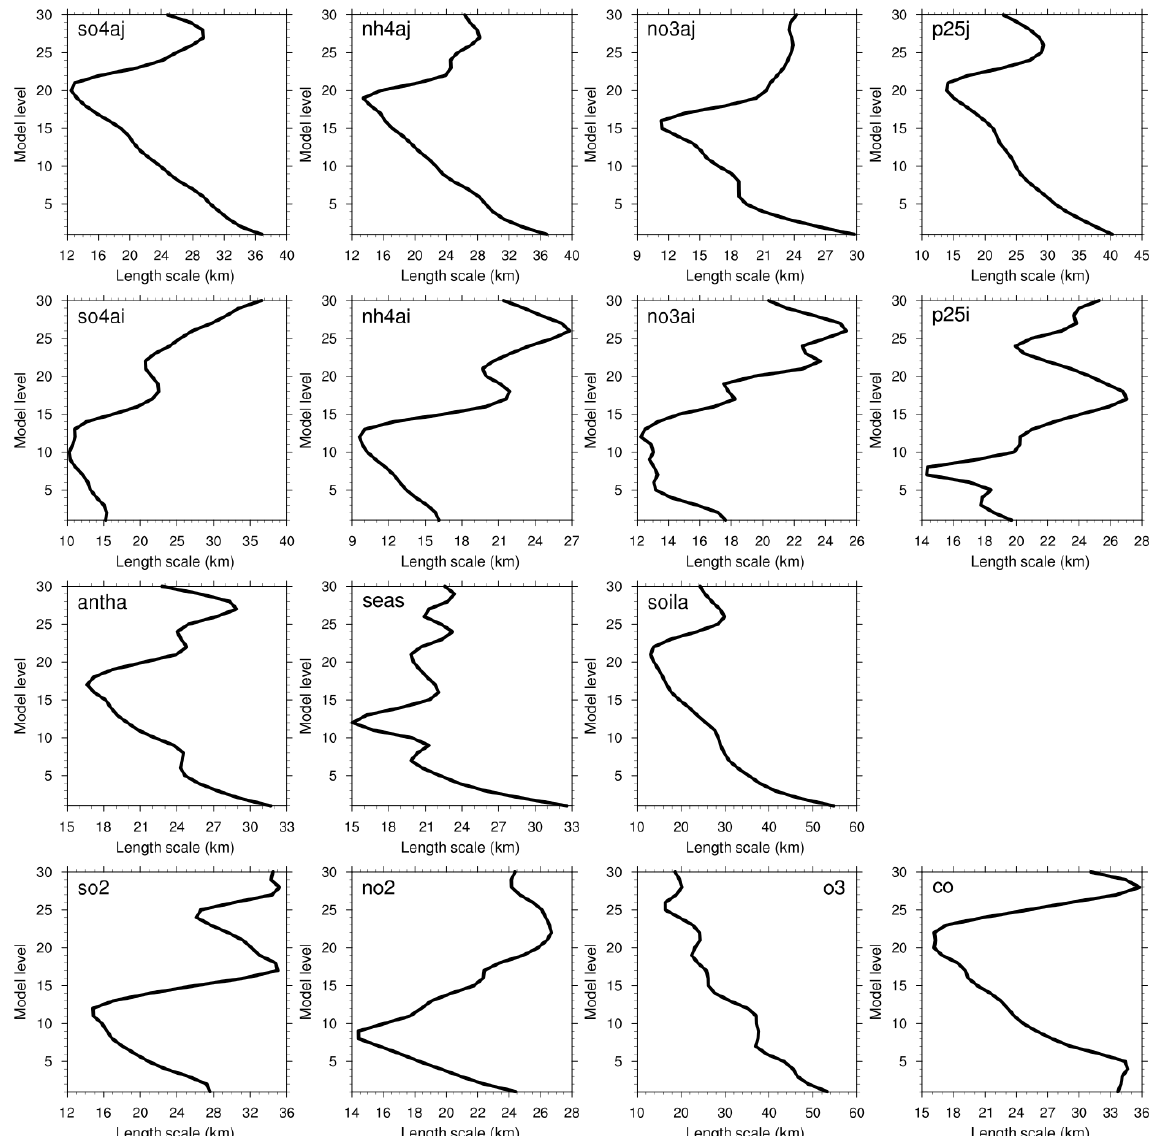
Figure 4. The horizontal length scales of the same species as in Fig.